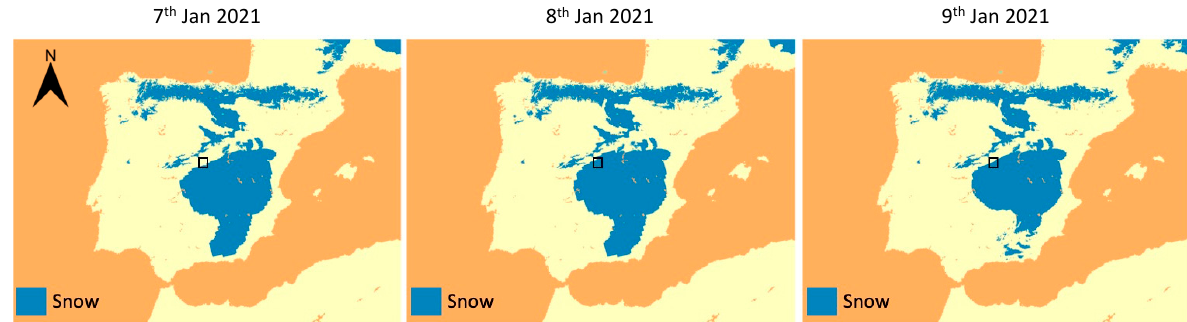
Figure 7. 4 km resolution snow coverage estimate produced by the NOAA/NESDIS Interactive Multisensor Snow and Ice Mapping System (IMS) for the 7th, 8th and 9th of January 2021. Madrid area is boxed. Raw data from NOAA/NESDIS processed using UCLM’s Fortran programs and NCL scripts.